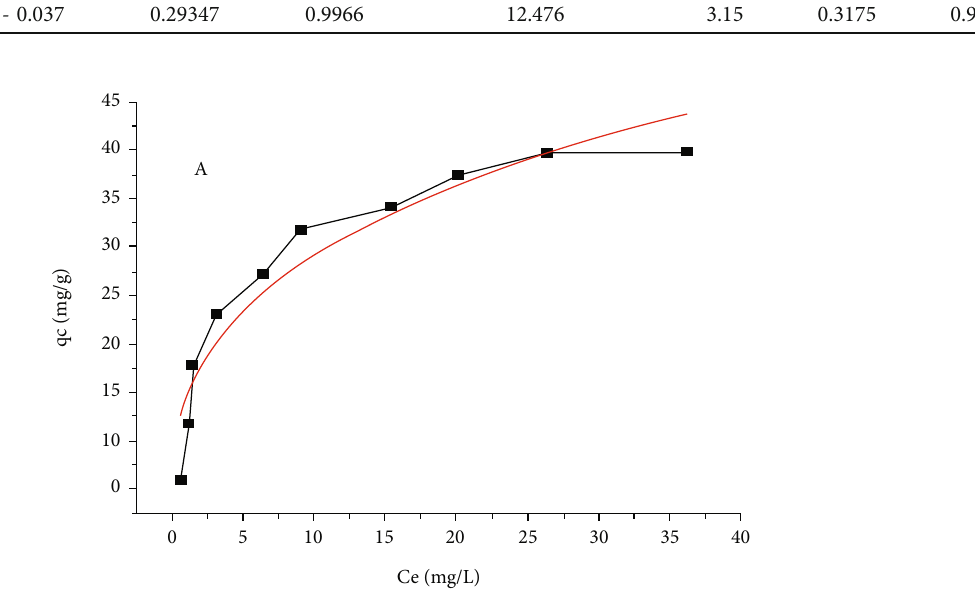
Figure 10: Freundlich nonlinear fi tting of adsorption isotherm for Cr(VI) ion adsorption.